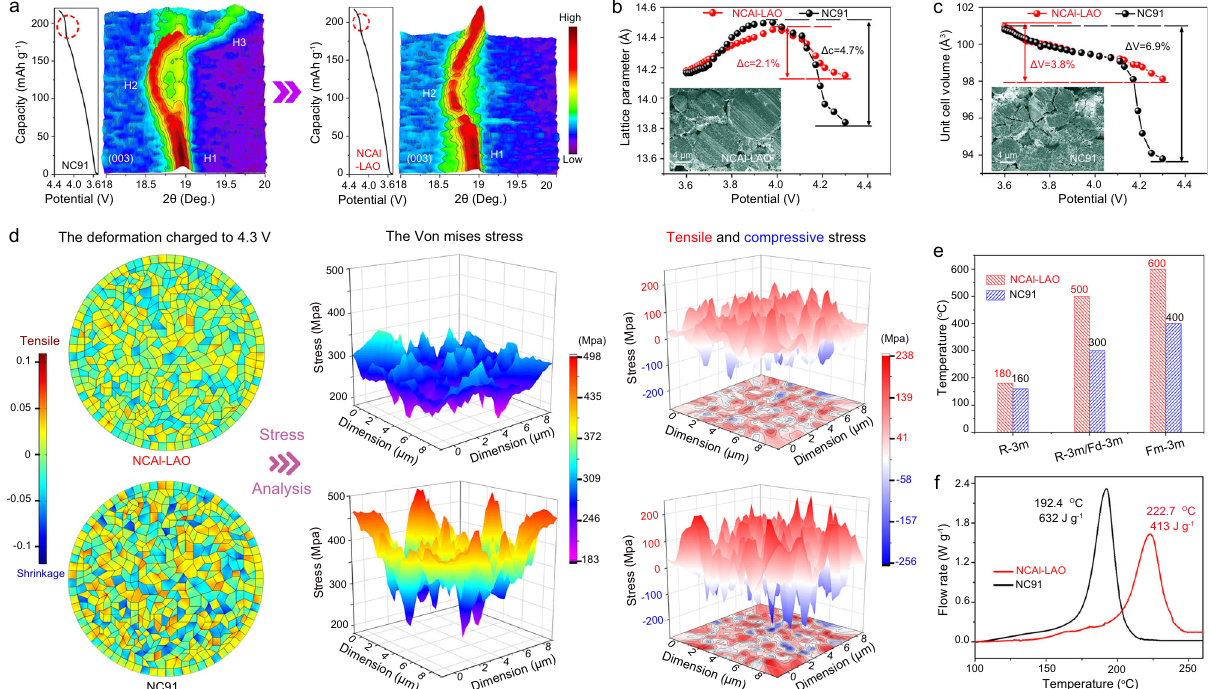
Fig. 4 Crystal structure, internal stress, and thermal stability of Ni-rich cathode. a Three-dimensional contour plots of (003) peaks from in situ XRD patterns for NC91 and NCAl-LAO with corresponding capacity vs. potential curves. Variations of b c -axis lattice parameters and c unit cell volume as a function of charging potential, and insets show cross-sectional SEM images of electrodes after 100 cycles. d Distributions of volume deformation, corresponding Von mises stress, tensile and compressive stresses through NCAl-LAO and NC91 when charging to 4.3 V. e Phase transformation temperature of NCAl-LAO and NC91 from HT-XRD patterns. f Differential scanning calorimetry pro fi les of NCAl-LAO and NC91 in delithiated state (charged to 4.3